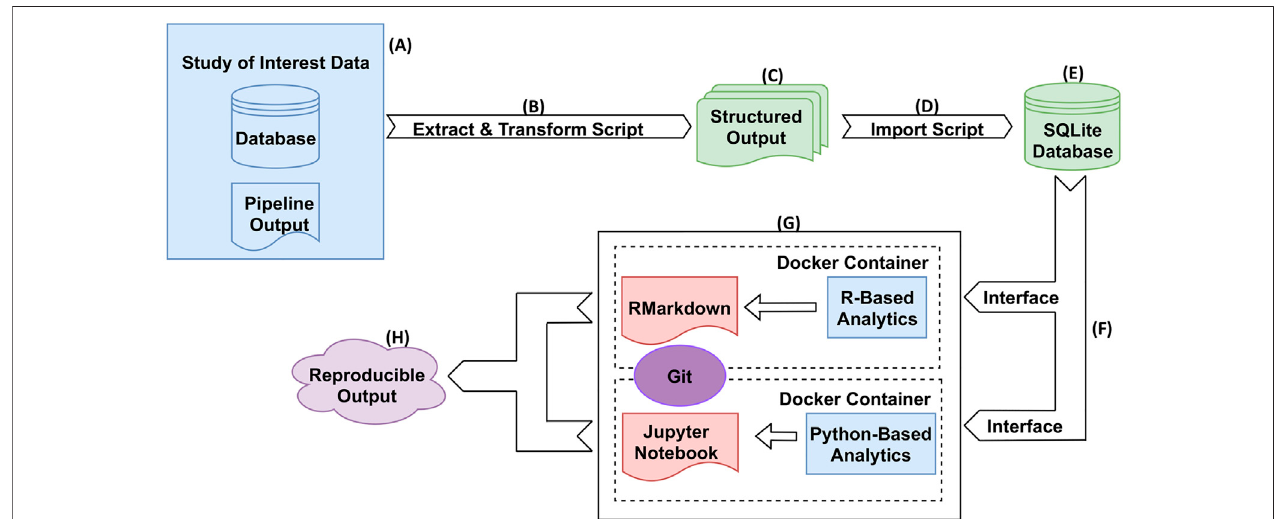
FIGURE 2 | NPARS Overview and Work fl ow. (A) Genomic pipeline output for a particular study of interest is identi fi ed. This output can be stored in a database(s) and/or inoutput fi les. (B) APythonscriptextractstheidenti fi edstudyresultsandtransformsthemintowell-de fi nedstructuredoutput fi les. (C) Thestructuredoutput fi les contain all data and metadata to be imported into the SQLite database. (D) A Python script imports the structured output fi les into the local SQLite database, which alreadyhasawell-de fi nedschematoholdthedata. (E) TheSQLitedatabase storesthescienti fi cstudydataandmetadatainawell-organized manner. (F) Theonly interfacebetweentheuserandthedata,isthroughtheparticularSQLiteAPIforthatdevelopmentenvironment.Forexample,RprovidestheRSQLitelibrarythatprovides accesstothedata. (G) Eachanalysisenvironmentisanabstraction(container)withinaDockercontainerandthesourcecodeforitischeckedintoGit.Self-documenting coding technologies such as R/RMarkdown and Python/Jupyter Notebooks, are used to perform the desired analyses. (H) Reproducible reports/analyses are generated, that are both portable and reproducible.